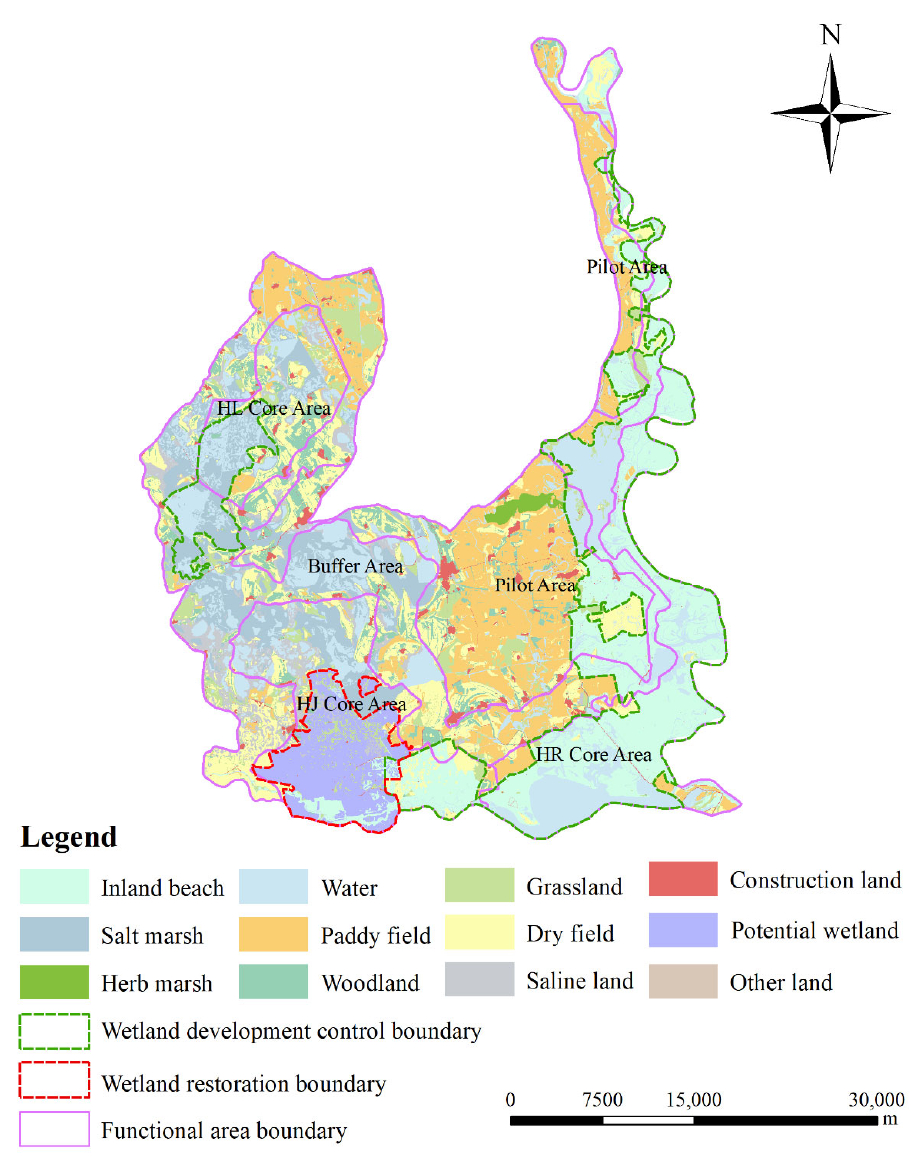
Figure 11. Momoge Internationally Important Wetland conservation spatial pattern optimization for 2019.